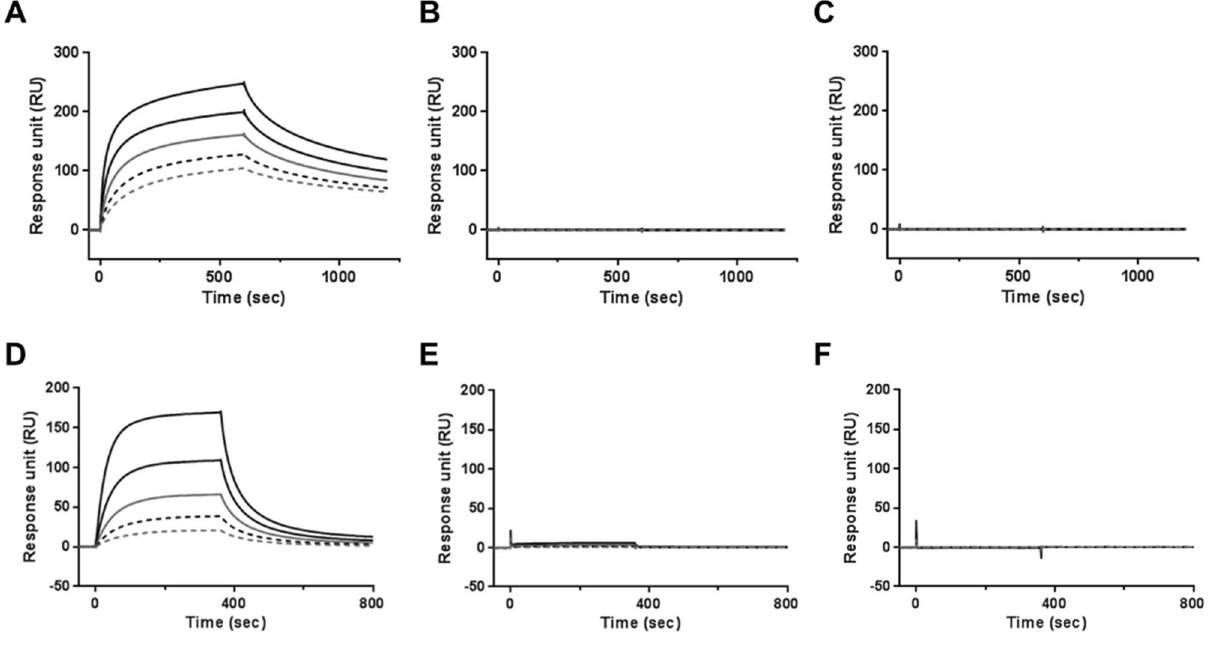
Figure 3. HM15136 interacts with FcRn and does not bind FcγR. The sensorgrams for the FcγRIA ( A–C ), C1q ( D–F ) binding of IgG1 (= I.V.-Globulin SN), HMC001, and HM15136. IgG1 control ( A,D ), HMC001 ( B,E ) and HM15136 ( C,F ). The concentration of individual test from top to bottom were 500 nM, 250 nM, 125 nM, 62.5 nM, and 31.25 nM for IV-Globulin SN ( A ) and HMC001 ( B ) and 486 nM, 243 nM, 121.5 nM, 60.75 nM, and 30.38 nM for HM15136 ( C ). The concentration of the individual test agents: IV-Globulin SN ( D ), HMC001 ( E ), and HM15136 ( F ) from top to bottom were 50 nM, 25 nM, 12.5 nM, 6.25 nM, 3.125 nM for determined using an enzyme-linked immunosorbent assay (ELISA). PK parameters were calculated by non- compartmental analysis using PhoenixTM WinNonlin® 8.0 (Pharsight, USA). The mean concentration versus time profiles of HM15136, and the corresponding PK parameters are summarized (Fig. 4 and Table 1). Mouse PK properties of HM15136 were evaluated after a single intravenous (IV) administration at a dose of 260 μg/kg and following subcutaneous (SC) administration at doses of 260 μg/kg, 519 μg/kg, and 1558 μg/kg in male mice (Institute for Cancer Research [ICR] mice) (n = 3/time point). Blood was collected from the retro- orbital plexus throughout 336 h post dosing. The mean serum concentration–time profiles of HM15136 obtained after IV and SC administration to mice are shown in Fig. 4A. After single IV administration of HM15136 at a dose of 260 μg/kg in mice, AUC last was 89,253.7 ng∙h/mL, C 0 5495.1 ng/mL,V d 214.6 mL/kg, and CL was 2.7 mL/h/ kg, indicating low clearance. After single SC administration of HM15136 at doses of 260 μg/kg, 519 μg/kg, and 1558 μg/kg in mice, AUC last values were 68,605.9 ng∙h/mL, 268,111.5 ng∙h/mL, and 1,509,634.6 ng∙h/mL, respectively; C max values were 1263.9 ng/mL, 4508.3 ng/mL, and 22091.1 ng/mL, respectively; T max was 24.0 h for all groups; t 1/2 values were 32.3 h, 56.2 h, and 53.8 h, respectively. SC bioavailability based on AUC last was 76.9% in the 260 μg/kg dose group and more than 100% in the other groups. Power model analysis revealed that the increase in the AUC last and C max values of HM15136 over the range of 260 to 1558 μg/kg was greater than a dose-dependent increase (Table 1). These data from a mouse PK study indicate that HM15136 has a lower clearance rate than native glucagon. Rat PK properties of HM15136 were evaluated after a single IV administration at a dose of 260 μg/kg and after SC administration at doses of 260 μg/kg, 519 μg/kg, and 1558 μg/kg in male SD rats (n = 3/group). Blood was collected from the jugular vein throughout 336 h post dosing. The mean (± S.D.) serum PK profiles are shown in Fig. 5B. After a single IV administration of HM15136 at a dose of 260 μg/kg in rats, AUC last was 112,670.4 ± 22,228.3 ng∙h/mL, C